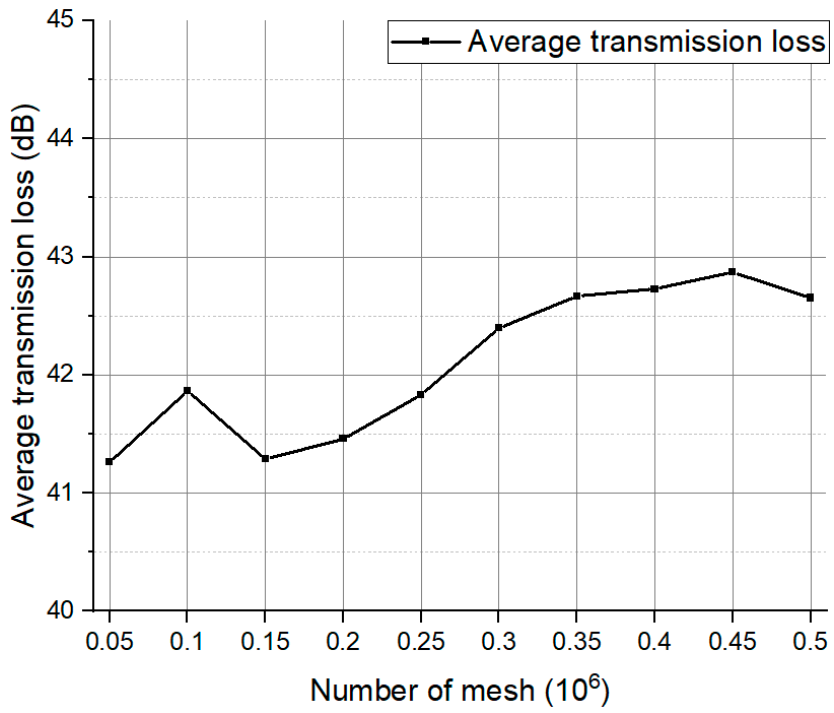
Figure 4. Transmission loss with the number of grids.